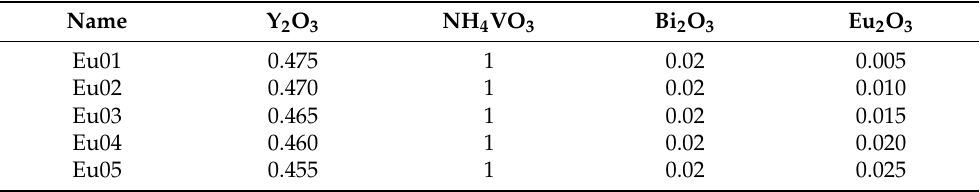
Table 2. The names and corresponding molar ratios of raw materials for the examined YVO 4 :0.04Bi 3+ , Eu 3+ samples.